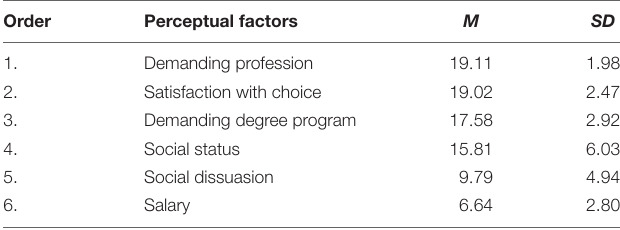
TABLE 4 | Means and standard deviations of perceptions.